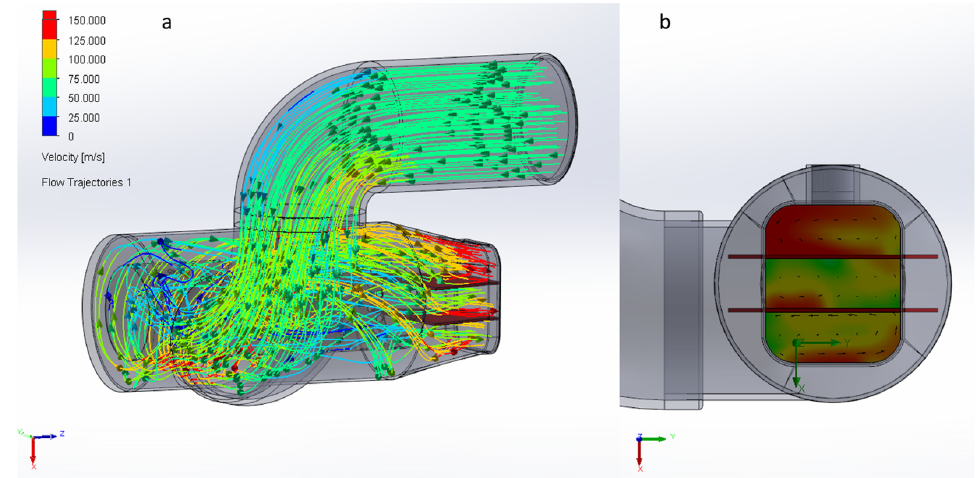
Figure 11. A second fin corrects the tumble.